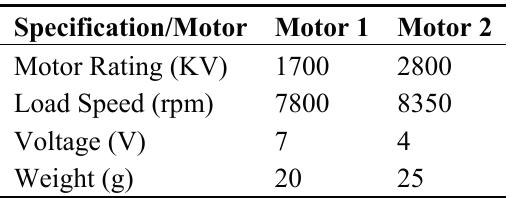
Table 7. Motor specification